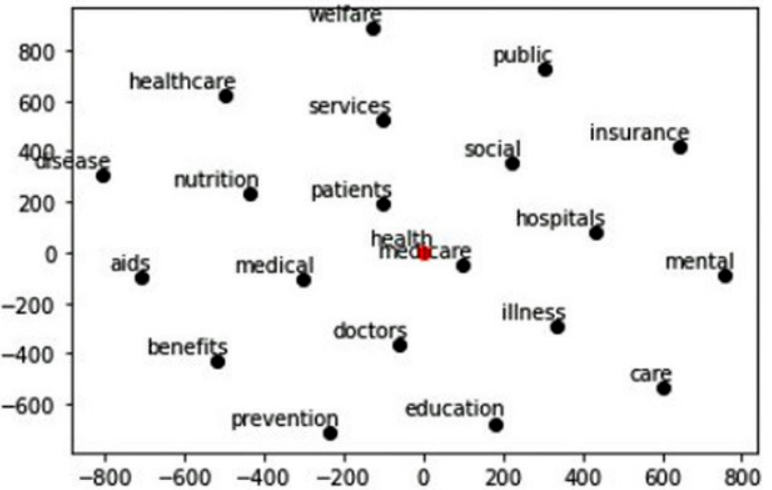
Figure 11. Health: probability analysis. Schematic representation of the probability distribution of the word “health” which is represented by a “red” dot in the drawing above.